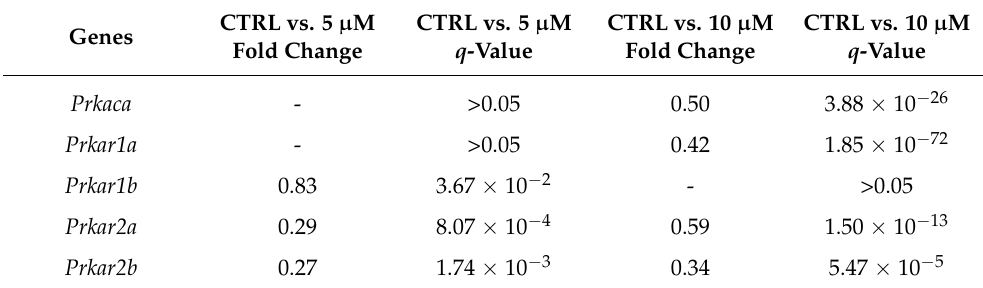
Table 2. DEGs of the subunits of the PKA protein. CTRL vs. 5 µ M Genes Fold